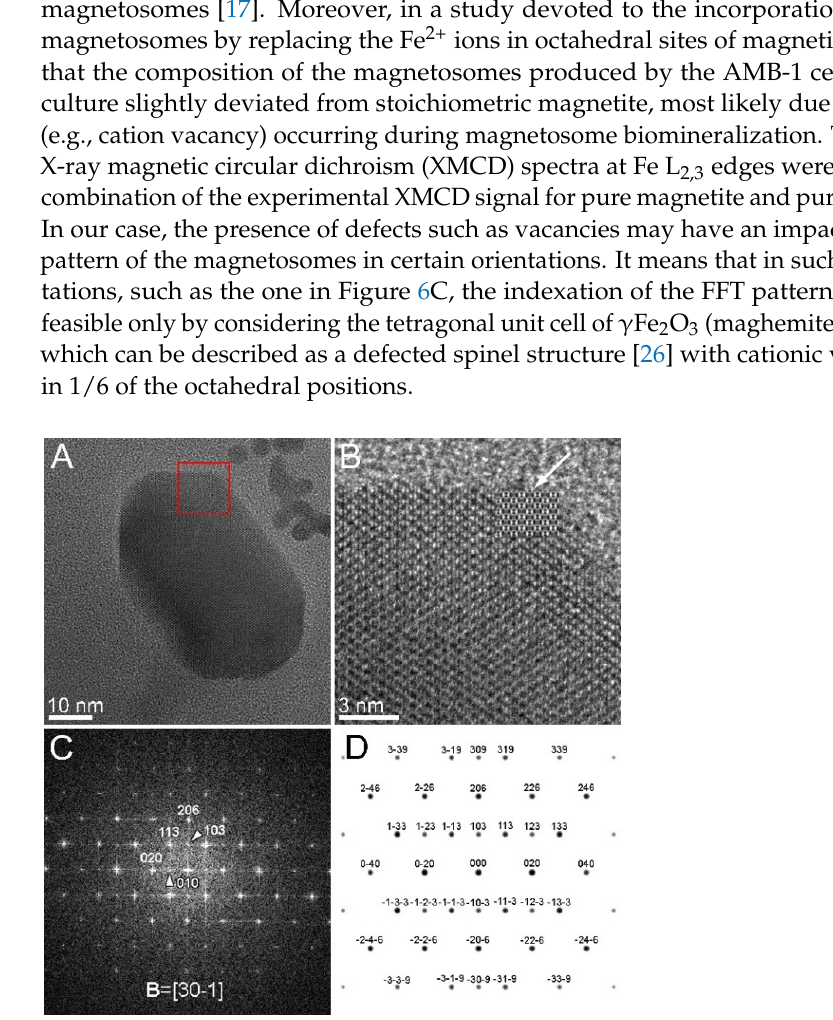
Figure 6. ( A ) HRTEM micrograph of the nanograin denoted by “1” in Figure 5. ( B ) Enlarged image of the upper-right corner of the nanograin showing the detailed HRTEM pattern. ( C ) FFT micrograph corresponding to the area delimited by the red square in ( A ). ( D ) Simulated SAED pattern considering the tetragonal unit cell of maghemite (cif No. 9006318).